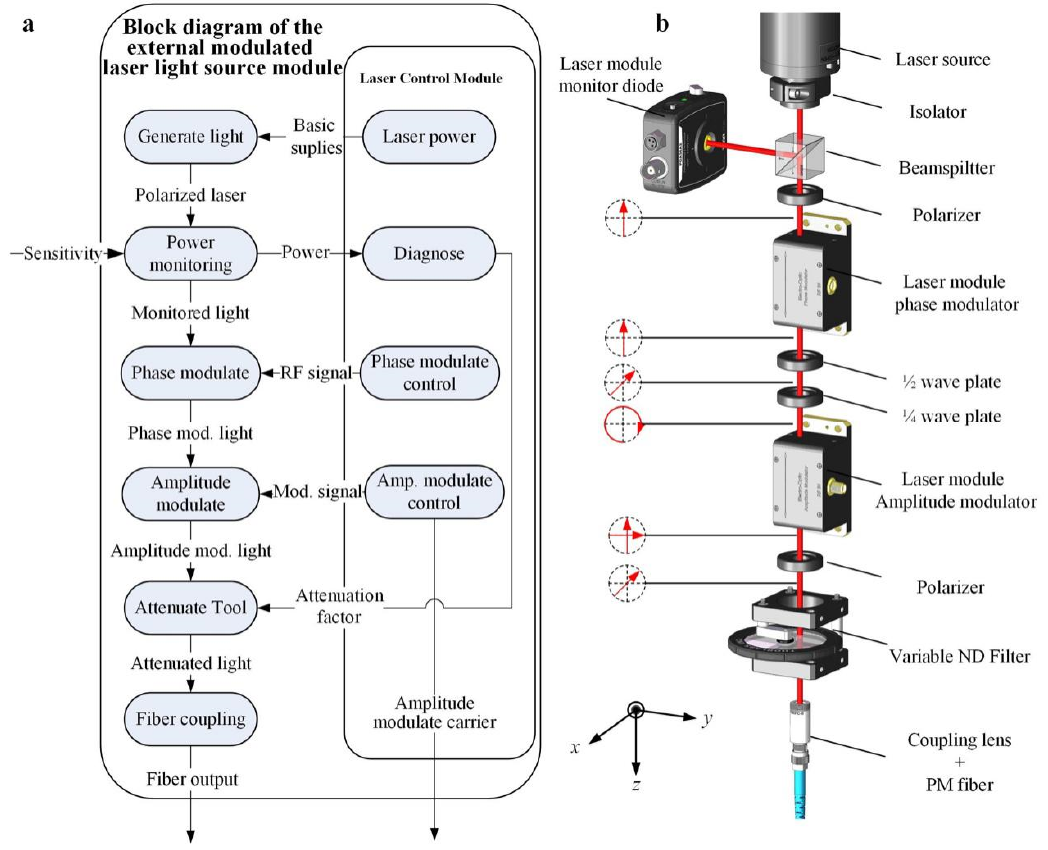
Figure 4. ( a ) Schematic functional block of external modulation laser module assembly (EMLMA). ( b ) Schematic of mechanical layout of EMLMA.